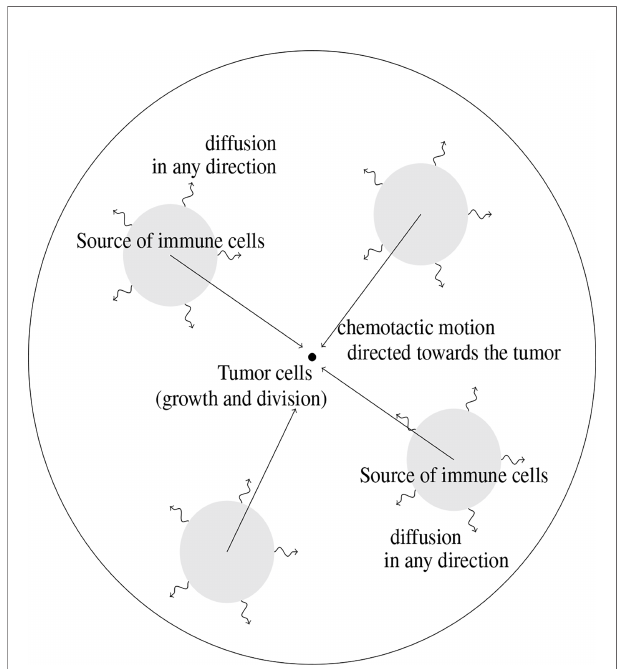
FIGURE 1 | Schematic view of the geometry of the mathematical model. The tumor cells are located at the center of the domain where they are subjected to growth and division mechanisms. Immune cells are activated from baths of resting cells; their motion is driven by diffusion combined to a convection fi eld, due to chemotactic mechanisms and directed towards the